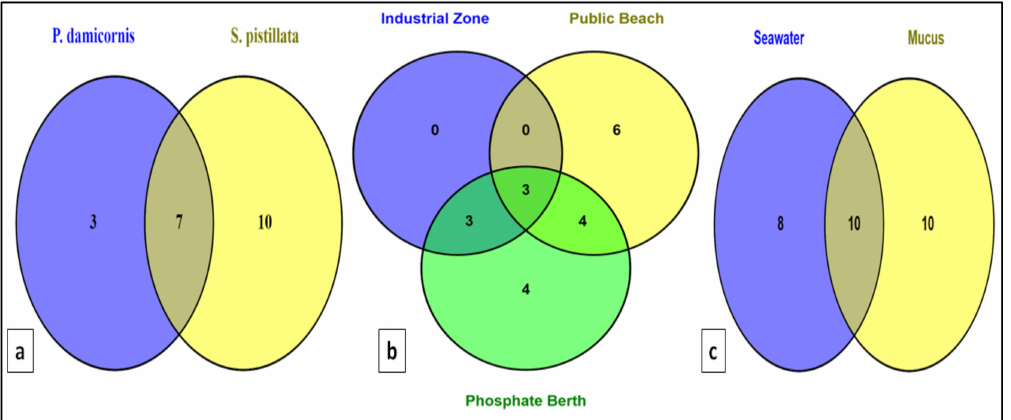
Figure 9. Distribution of shared and non-ubiquitous bacterial isolates ( a ) between coral species, ( b ) between sampling sites, and ( c ) between seawater and coral